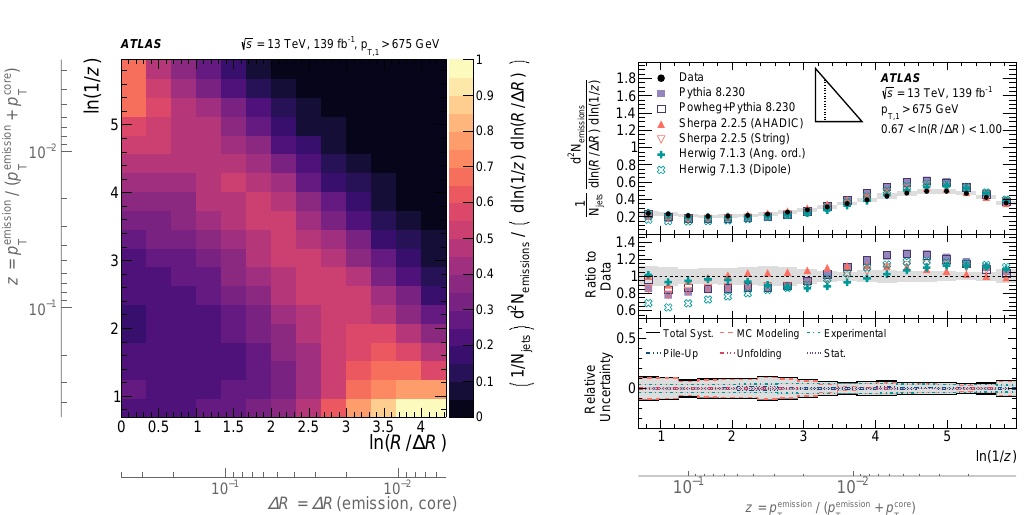
Figure 3: Two-dimensional probability density as a function of ln ( R / ∆ R ) and ln ( 1 / z ) (left) and distribution of ln ( 1 / z ) for 0.67 < ln ( R / ∆ R ) < 1.00 (right) [ 3 ]